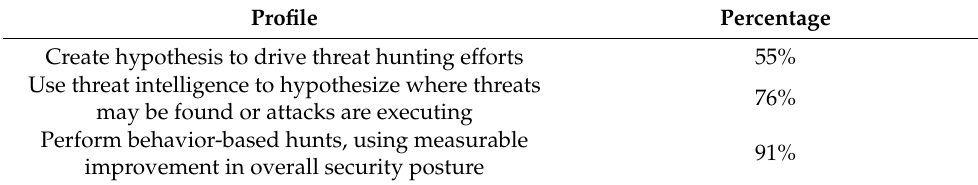
Table 5. Profiling enterprise threat hunting